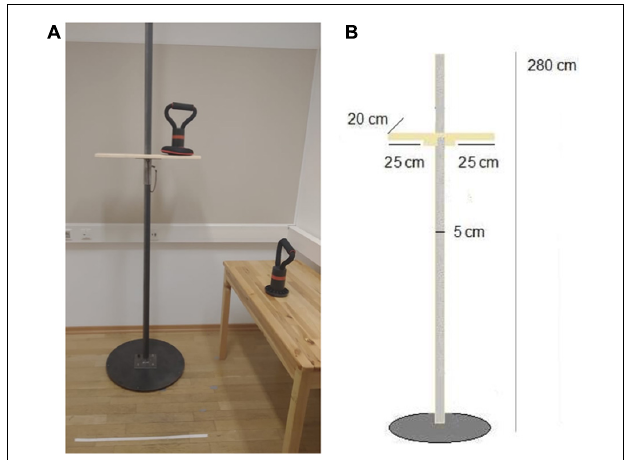
FIGURE 1 | Experimental setup with two example weights (light and medium) marked with horizontal red stripes where participants were asked to place their thumb while grasping the weight (A) . Dimensions of the shelf and pole (B)